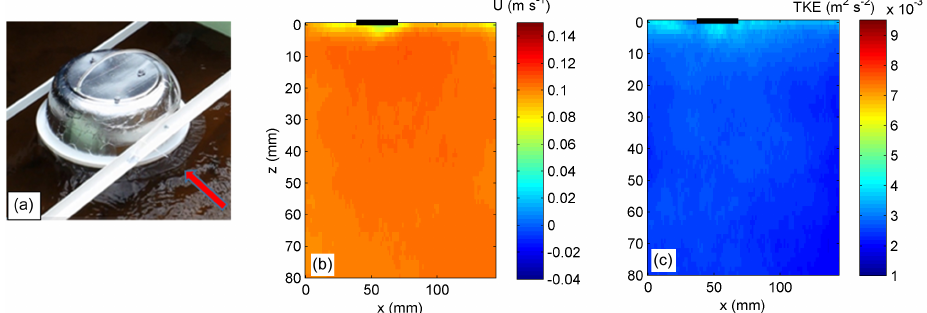
Figure 4. (a) Flying chamber design without penetration of the water surface by the chamber edges but using a plastic foil collar (marked by the red arrow) for sealing. The chamber is fixed above the water surface by a supporting frame. (b) Distribution of mean longitudinal flow velocities ( U) and (c) turbulent kinetic energy (TKE) of the flow field below the front edge of a piece of static foil (marked by the black bar) at the water surface. The direction of flow was from left to right; x and y refer to longitudinal distance and depth, respectively. The mean flow velocity was 0.10ms − 1 . Color scales are identical to that of Fig.